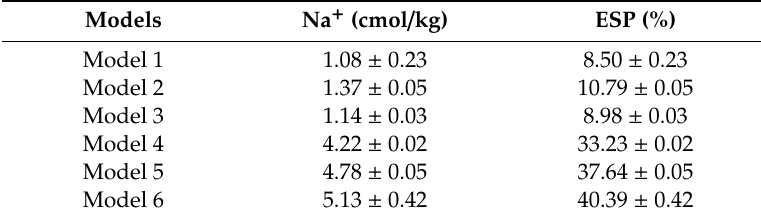
Table 6. Value of Na + exchanged and the percentage of exchangeable sodium (ESP) (%) of the